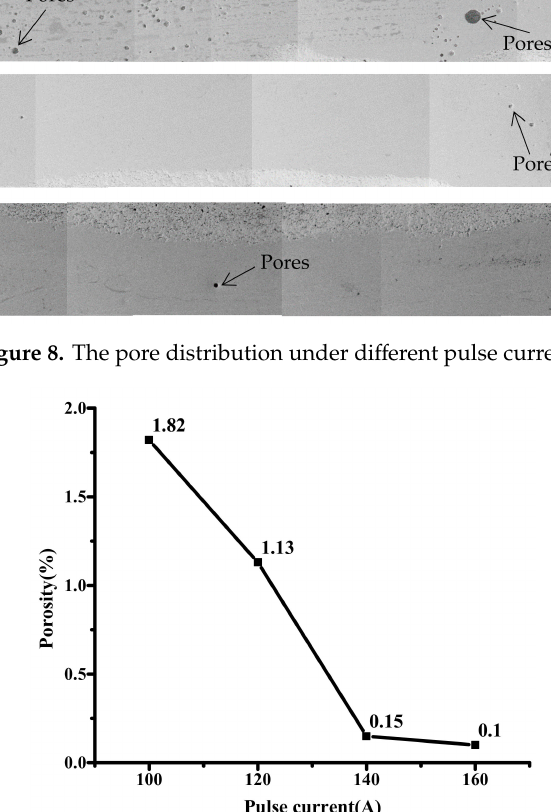
Figure 9. The porosity variation curve of the sealing layer under di ff erent pulse